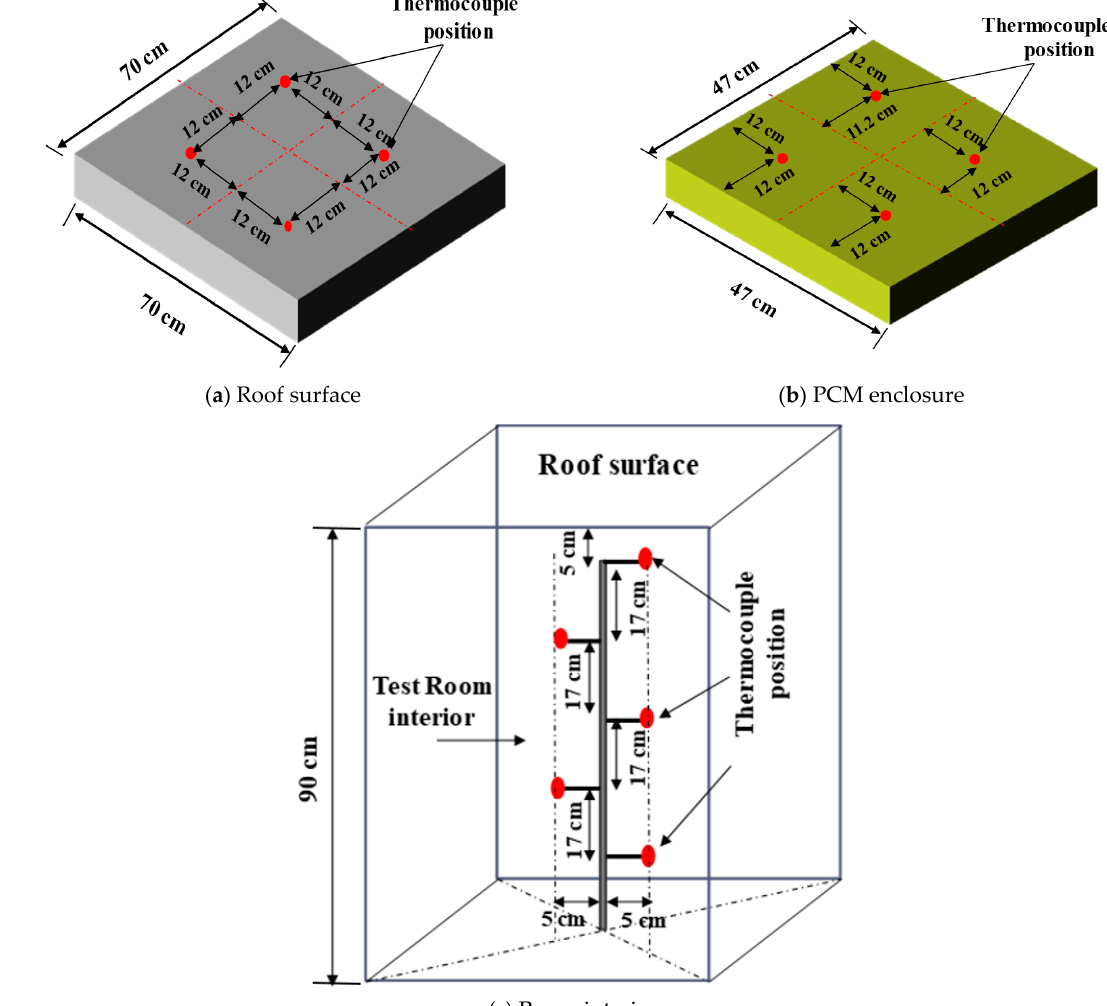
Figure A2. Position of thermocouples.